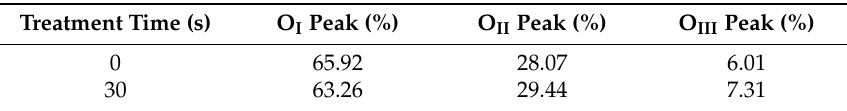
Figure 9. XPS spectra and the Gaussian-resolved components of the O 1s peak of FZO films on unmodified and 30 s pretreated PI substrates. ( a ) Unmodified and ( b ) O 2 plasma pretreatment time of 30 s. Table 1. Area of the O 1s peak of F-doped ZnO (FZO) films on unmodified and 30 s pretreated polyimide (PI) substrates.